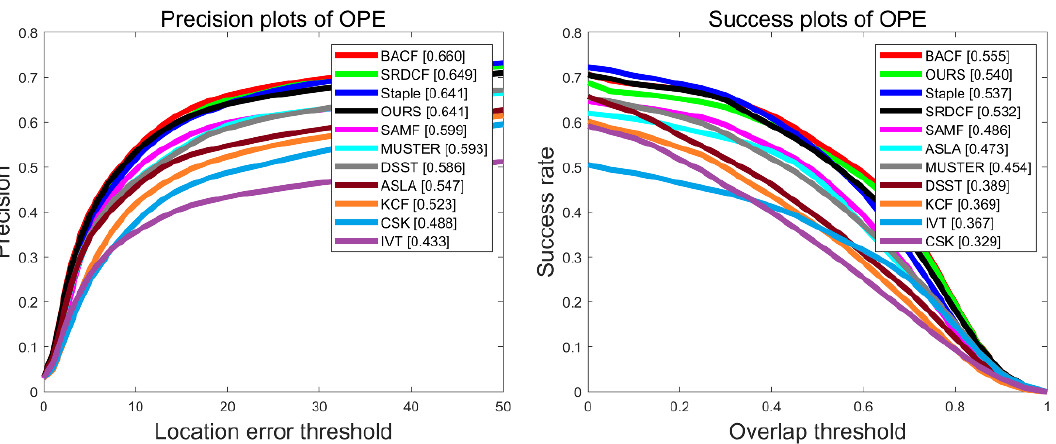
Figure 12. Accuracy and success rate plots of different algorithms tested on the UAV123 dataset. Table 3. Average performance of algorithms tested on the UAV123 dataset.